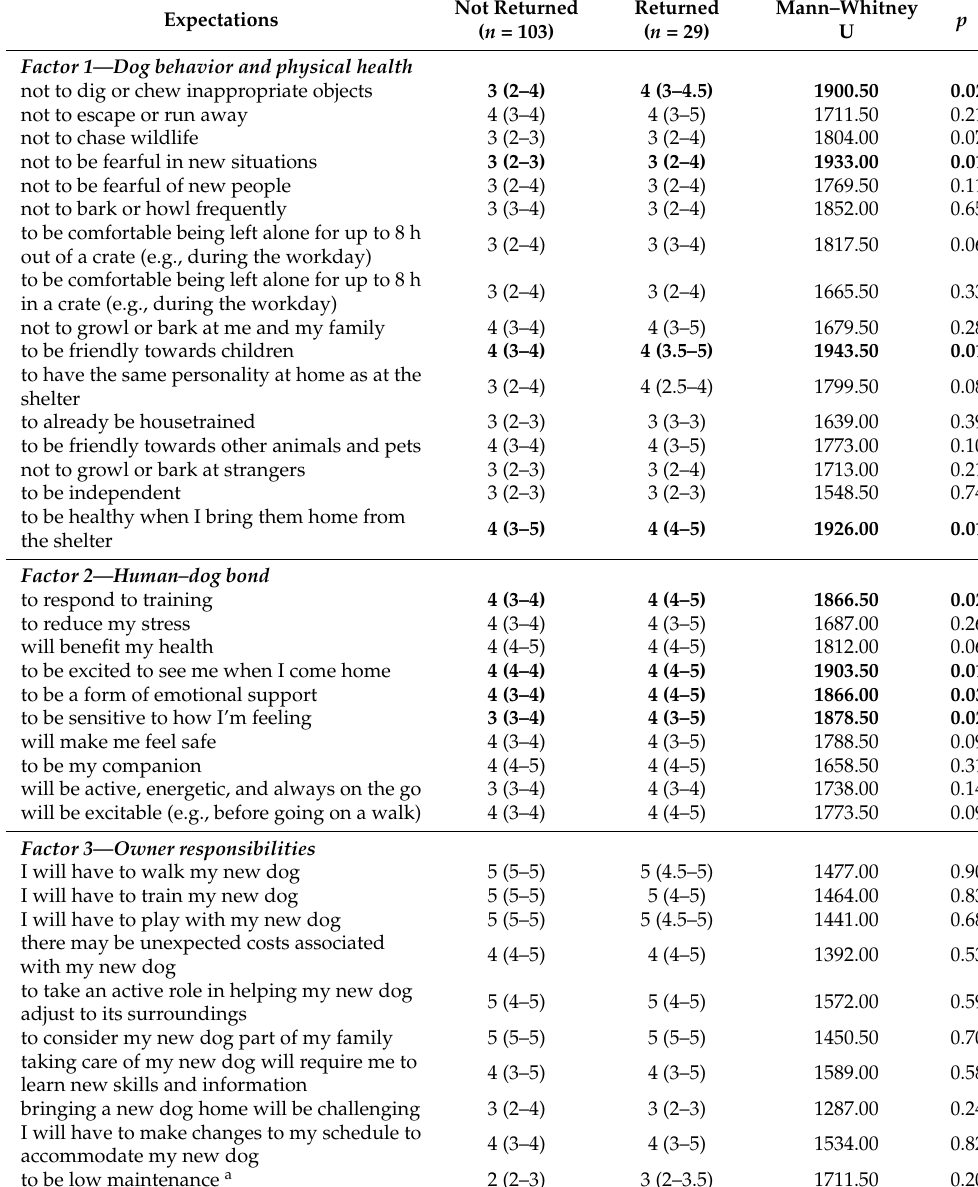
Table 3. Expectations by return